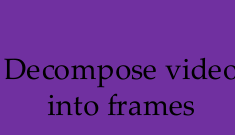
Figure 9. The overall structure illustration of FSSD. The arrows show the information flow. The box of “Detection” is the detector, which output the classes and location of the object in the image or frame.